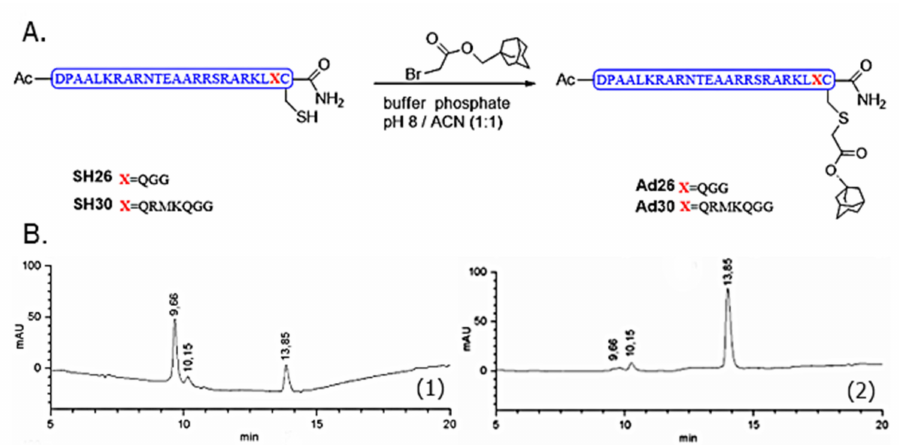
Figure 3. ( A ) GNC4 peptides derivatives. ( B ) RP-LC–MS-monitoring of the reaction between